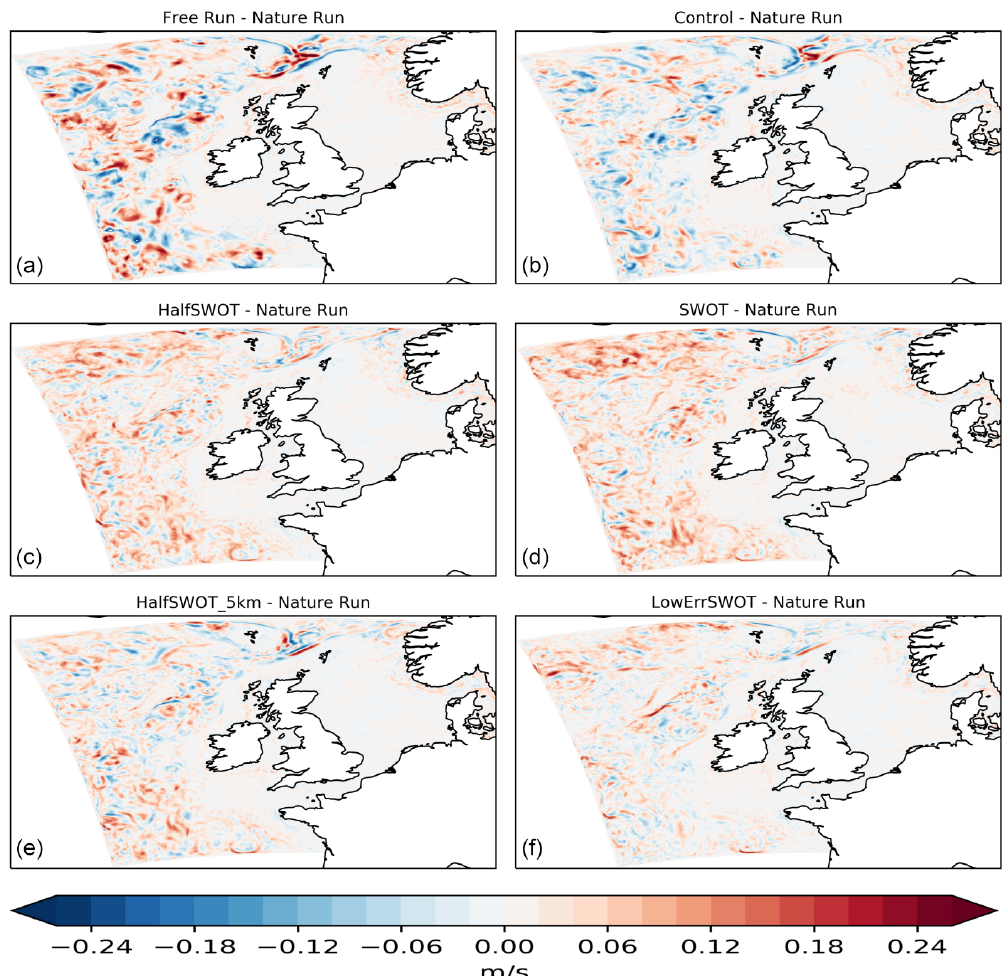
Figure 15. Monthly (June 2018) mean surface current speed error (compared to the nature run) from the free run (top left), control, HalfS- WOT, SWOT, HalfSWOT_5km and LowErrSWOT experiments